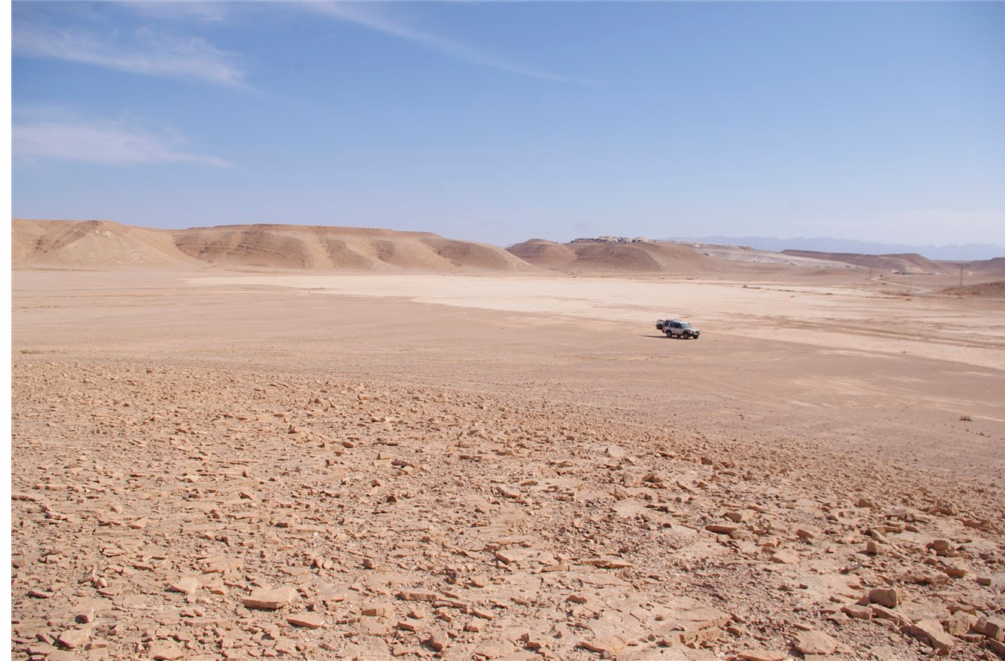
Figure 9. Shaharut Playa (Qa Shaharut), an eastward sight. Picture taken by Ilan